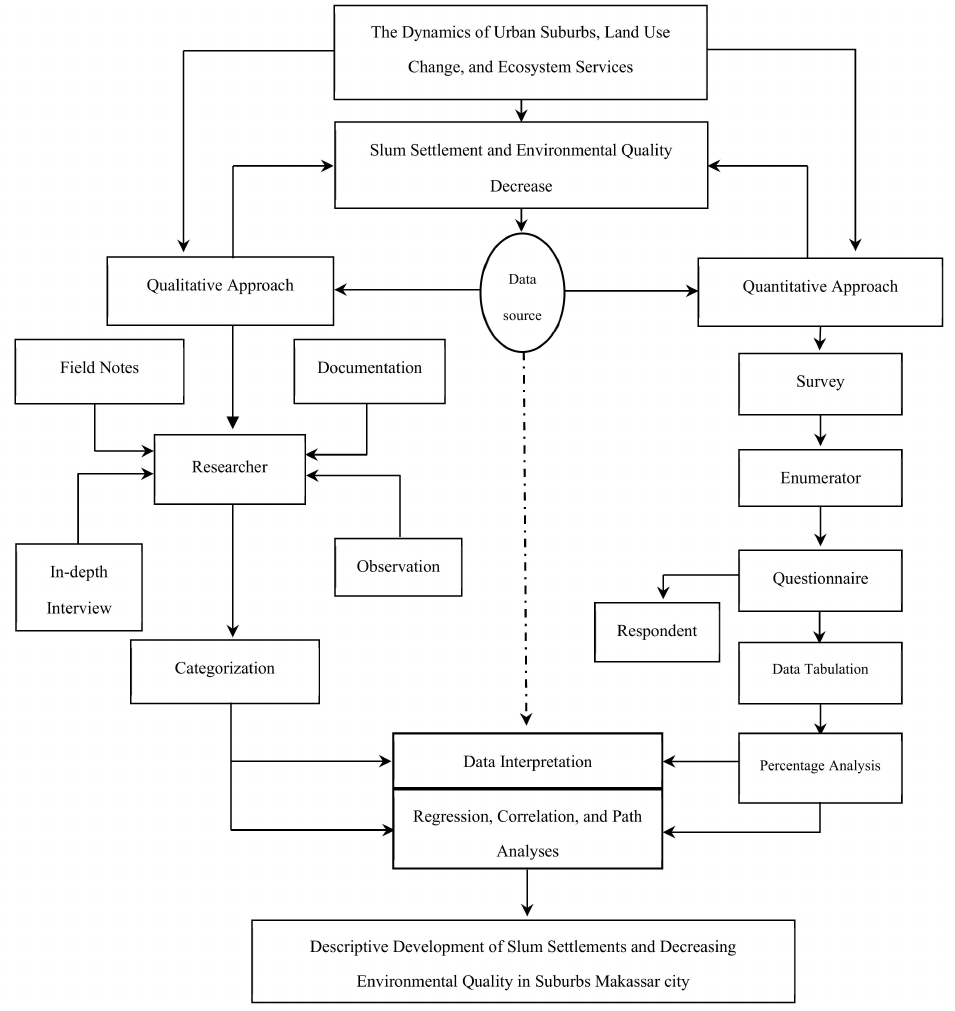
Figure 2. Research process